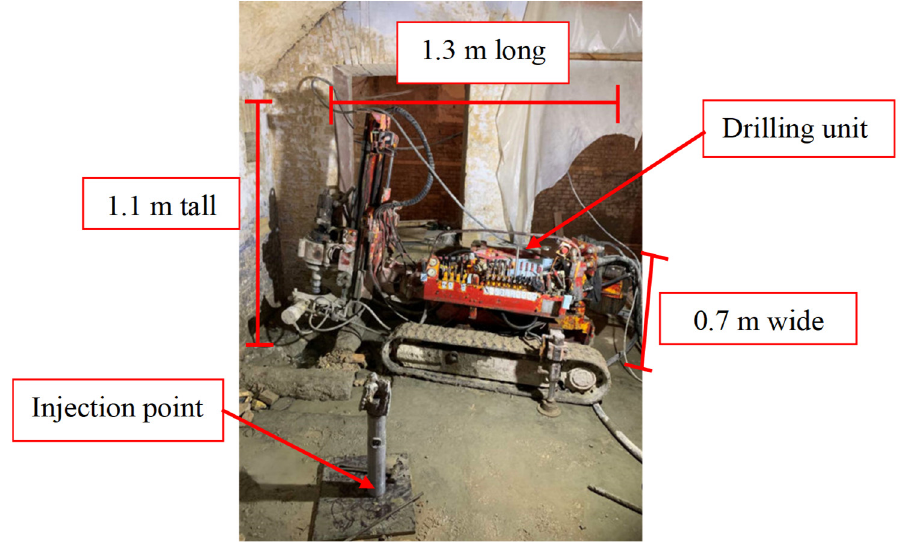
Figure 6. Small drilling unit inside the building (source: authors).